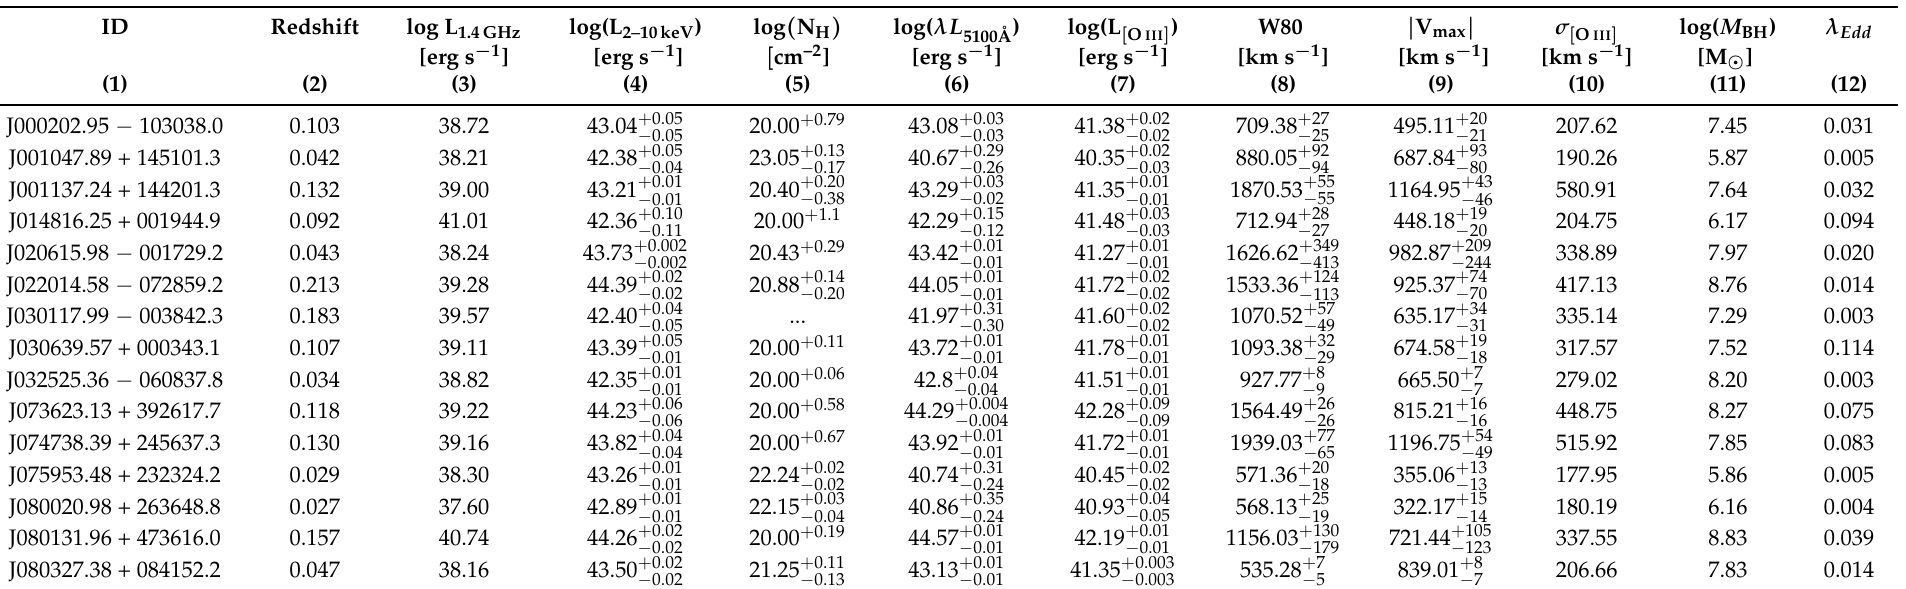
Table 1. Main parameters of our sample (183 targets) obtained from optical and X-ray